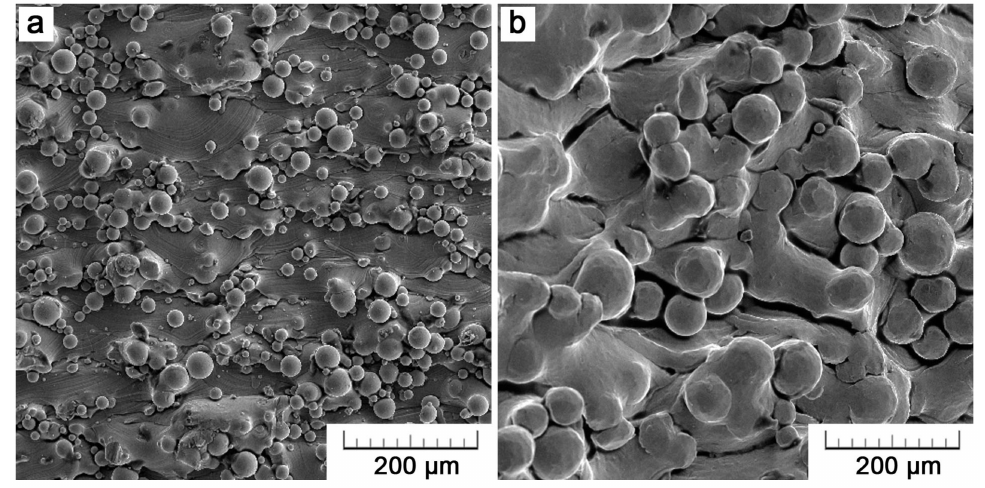
Figure 4. Surface morphology of Ti6Al4V specimens manufactured by ( a ) SLM and ( b ) EBM.